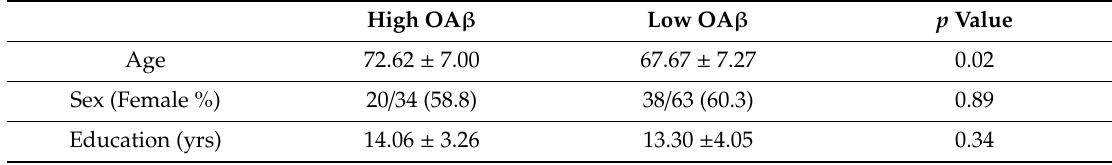
Table 1. Demographics and clinical data of the population of high and low group of plasma OA β levels. High OA